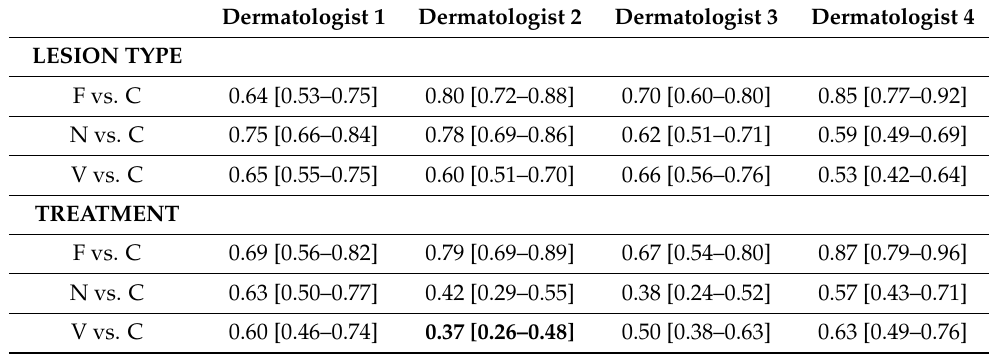
Table 2. Cohen’s K values with respective 95%